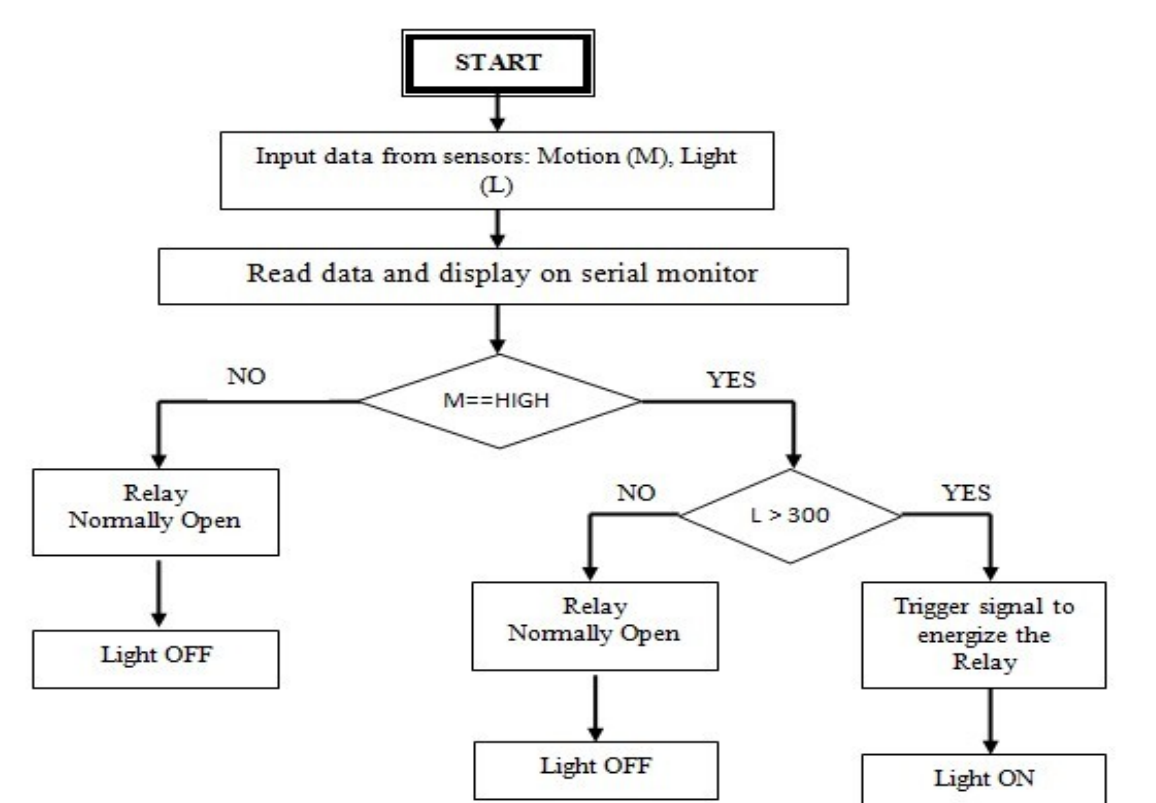
Figure 16. Lighting system smart control algorithm [21].